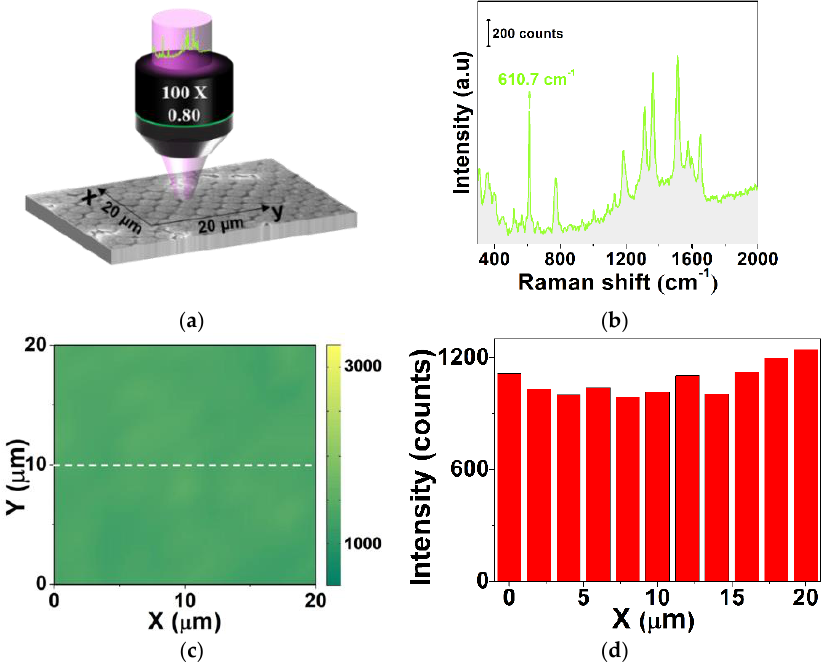
Figure 5. ( a ) Schematic diagram of Raman mapping excited via a focused Gaussian beam. ( b ) A typical Raman spectrum of R6G with a solution of 10 −5 M absorbed on the SERS substrate with a Ag film thickness of d = 10 nm, and the intensity of the Raman characteristic peak at 610.7 cm −1 was adopted to achieve Raman mapping. ( c ) Raman mapping result with a square of 20 × 20 µ m using the intensity of the Raman characteristic peak. ( d ) Histogram of the intensities of the 610.7 cm − 1 characteristic perk obtained along the white curve in ( c